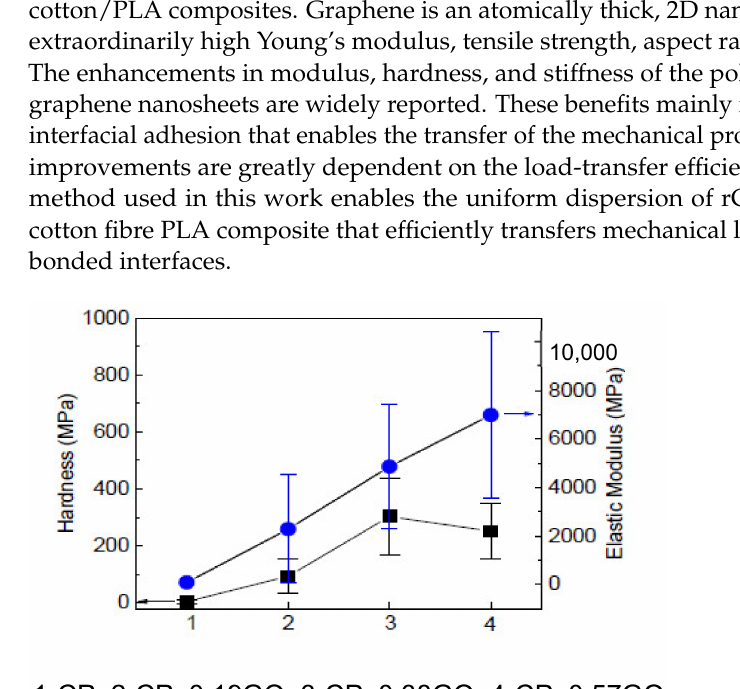
Figure 6. Nano-indentation properties of cotton/PLA composites with and without GNP